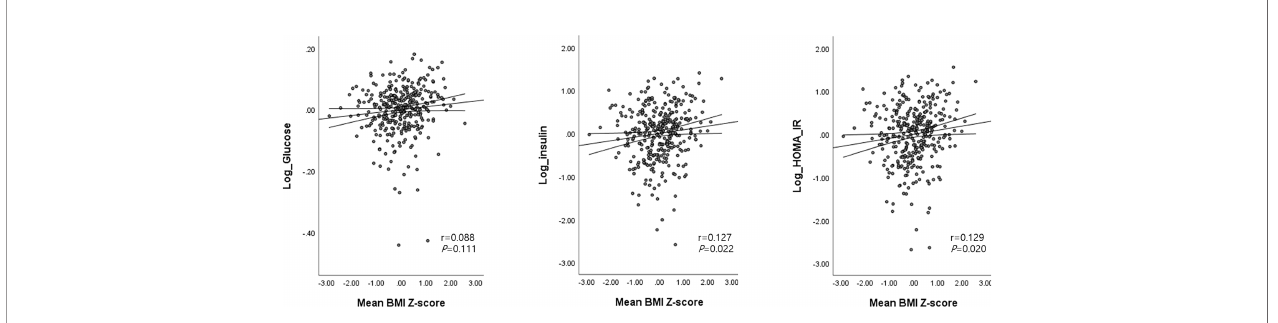
FIGURE 3 | Associations between the mean BMI Z-score at ages 2 and 4 with glucose, insulin, and HOMA-IR levels at age 4. Age (months), sex, birth weight, gestational age, SGA, parental BMI, and maternal education were adjusted as covariates. Mean BMI Z-score at ages 2 and 4 = [(BMI Z-score at age 2 + BMI Z-score at